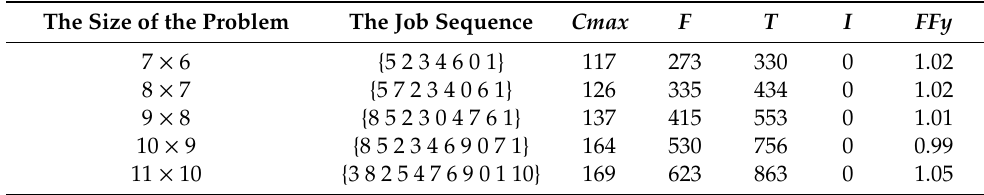
Table 4. The quality of best basic schedules obtained for job shop problems using the MOIA (Multi-objective immune